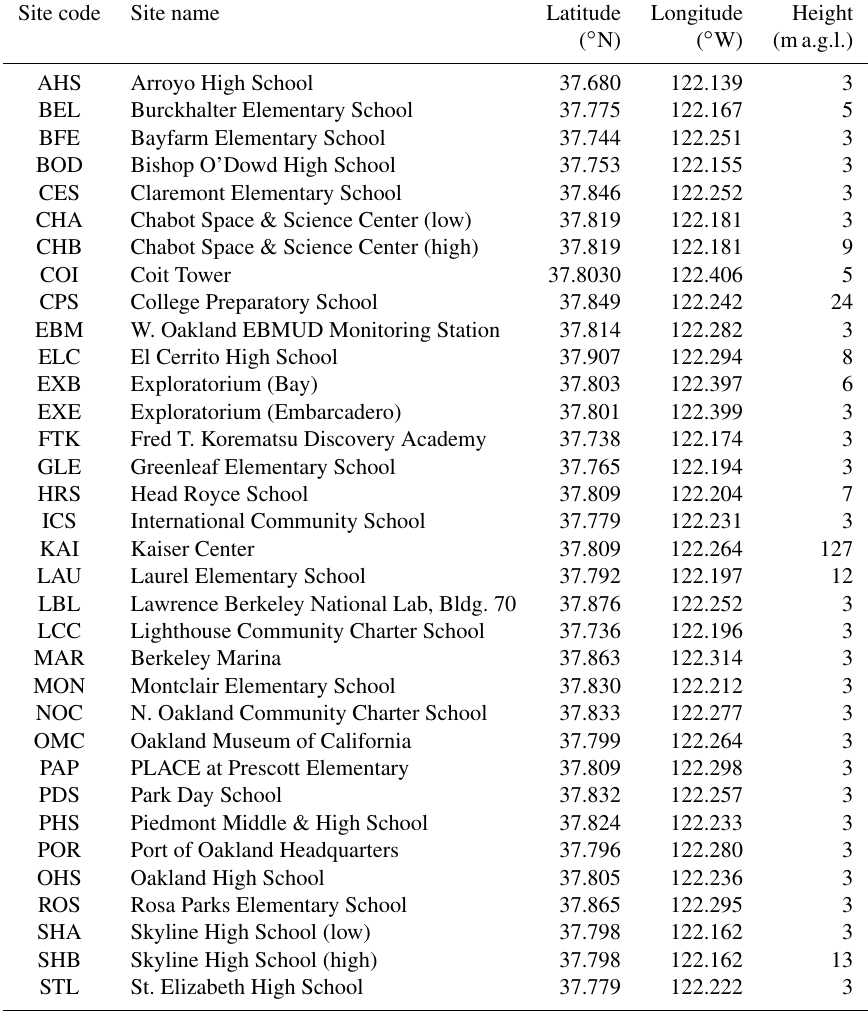
Table 1. The 34 sites in the network ∗ used in this study. Site